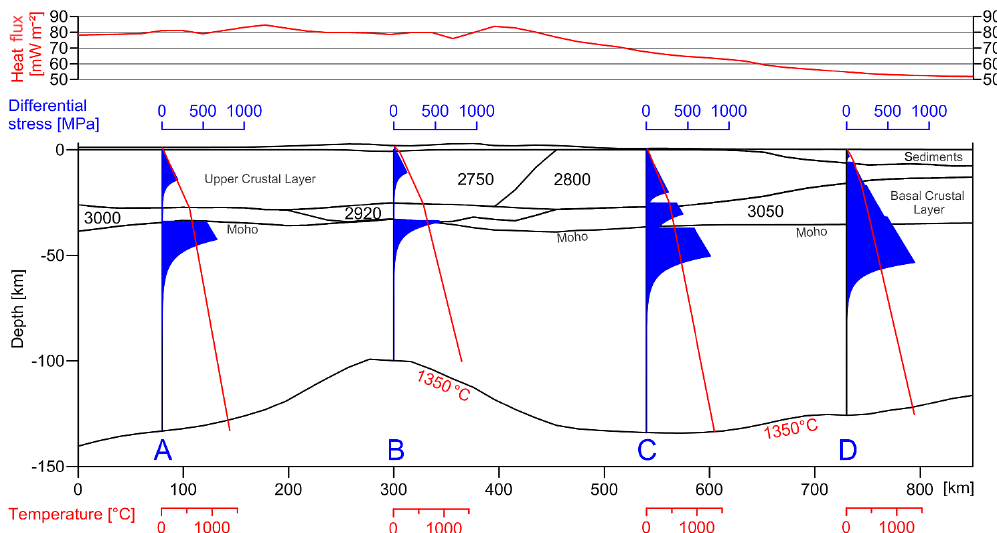
Figure 9. Across-rift profile through the 3-D structural model with yield-strength envelopes at four locations (A–D; locations in Figs. 8a and 10a); numbers in selected structural units indicate gravity-constrained density (kgm − 3 ) ; also shown are the geothermal gradients for the four locations and the along-section heat-flux